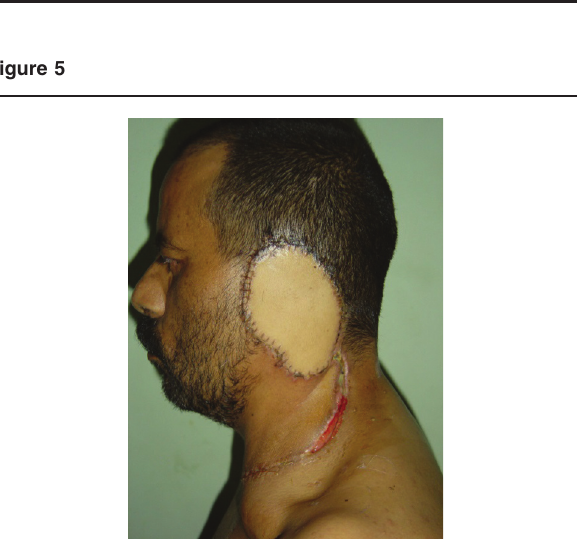
The whole specimen containing auricle, external auditory canal, and parotid gland removed en bloc of patient 1.